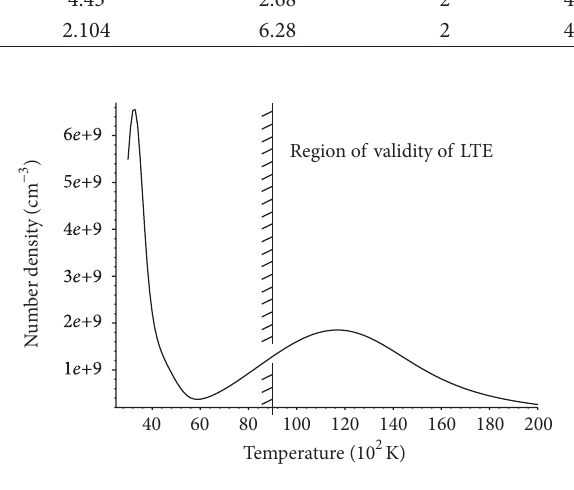
F 2: Population of excited level Mg(3p), as function of temperature, in the equilibrium plasma of MgCl concentrated at 50mg/L.